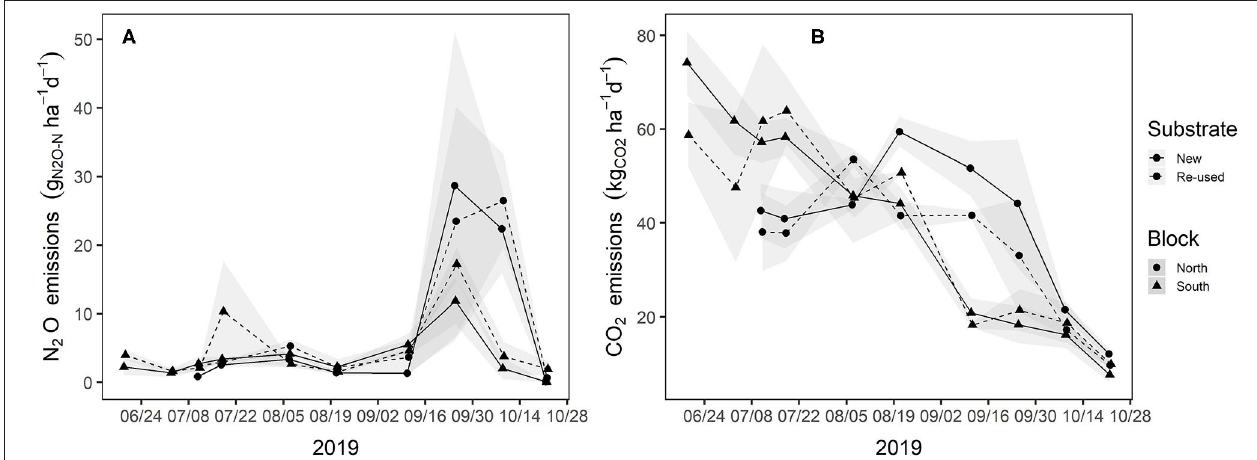
FIGURE 3 | Time series of N 2 O (A) and CO 2 (B) emission rates from the root zone of cucumbers grown on rock wool growing bags in an open-loop hydroponic system in the second half of 2019. Half of the studied rock wool growing bags were new (solid lines), while the other half was previously used in the first half of 2019 (Re-used, dotted lines). Due to a delayed delivery of seedlings, cultivation in the north block (circles) started 3 weeks later than in the south block (triangles) of the greenhouse. Symbols show mean values of n = 2 replicates and shaded areas the corresponding 95% confidence intervals.